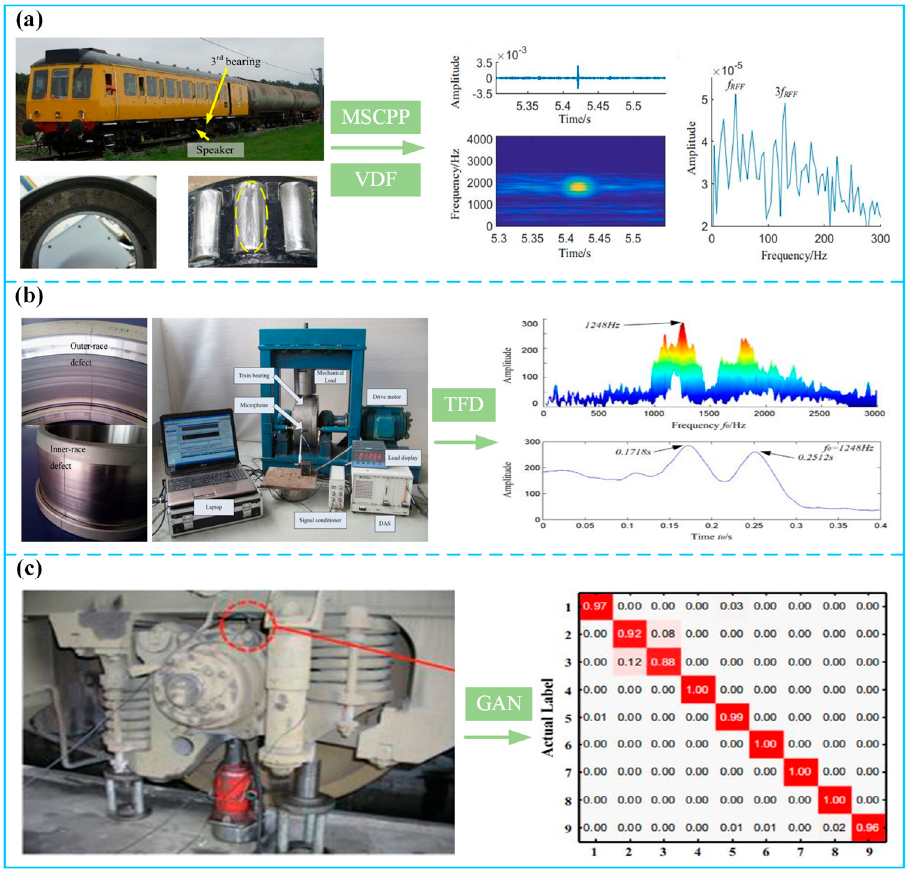
Figure 2. Fault diagnosis method of bearing: ( a ) multiscale chirp path pursuit (MSCPP) and variable digital filter (VDF) [9]; ( b ) time-frequency distribution (TFD) [17]; ( c ) generative adversarial network (GAN) [30].